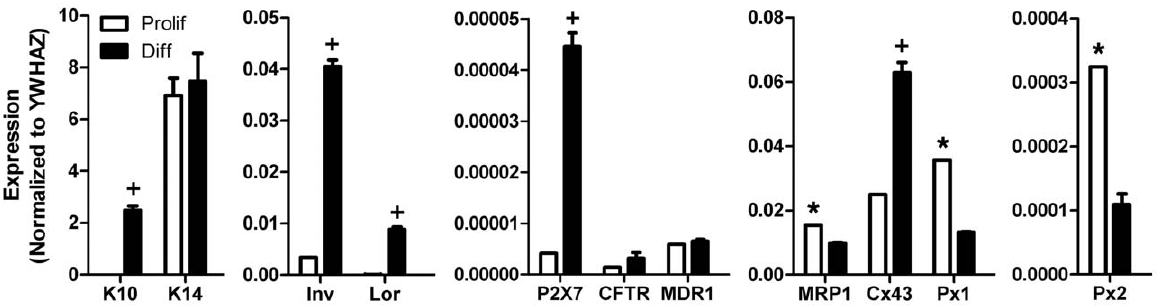
Figure 1. mRNA expression of putative ATP release pathways in NHEK. qPCR was used to assess potential ATP release pathways present in proliferating (white bars) and calcium differentiated (black bars) NHEK cultures. All non-vesicular ATP release pathways investigated were present in NHEK cultures. The P2X7 purinergic receptor, which is proposed to form an ATP permeable pore through an interaction with pannexins, was significantly increased in differentiated cells. The ABC transporters CFTR and MDR1 were not altered by differentiation, although the MRP1 ABC transporter showed a small, but significant increase. The hemichannel component connexin 43 (Cx43) was also increased by differentiation, while the other hemichannel components pannexin 1 and 2 (Px1 and 2) were significantly decreased. Large increases in the differentiation markers keratin 10 (K10), loricrin (Lor) and involucrin (Inv) verified the differentiation status of calcium treated cultures. The basal keratinocyte marker keratin 14 (K14) was similarly present in both proliferating and differentiated cultures. Values are shown relative to the housekeeping gene YWHAZ and represent data from 3 samples + / 2 SEM. Due to differences in expression levels, multiple Y axes are used. *significantly decreased in differentiated cells, + significantly increased in differentiated cells ( p ,